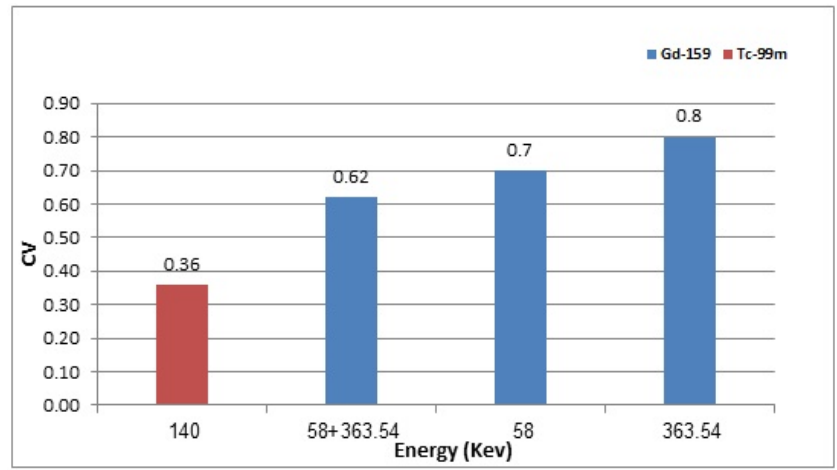
Figure 14. Coefficient of variation for the image acquired from 99m Tc and different photopeaks of 159 Gd using ImageJ software.